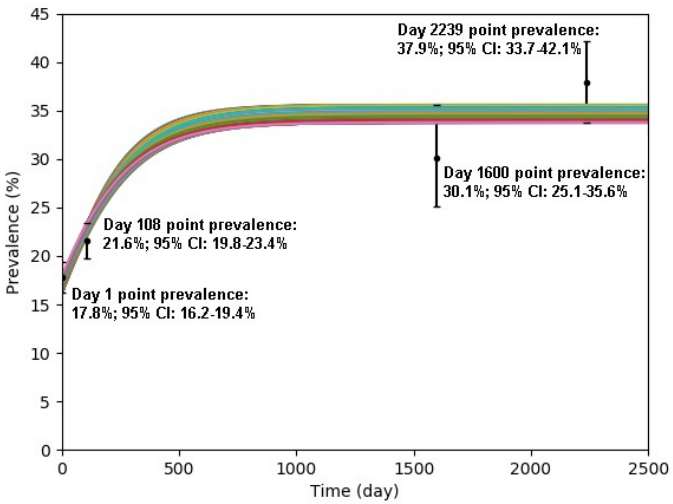
Figure 5. Plot of 487 simulation results that fitted within 95% CI of the four point-prevalence rates on their respective day.